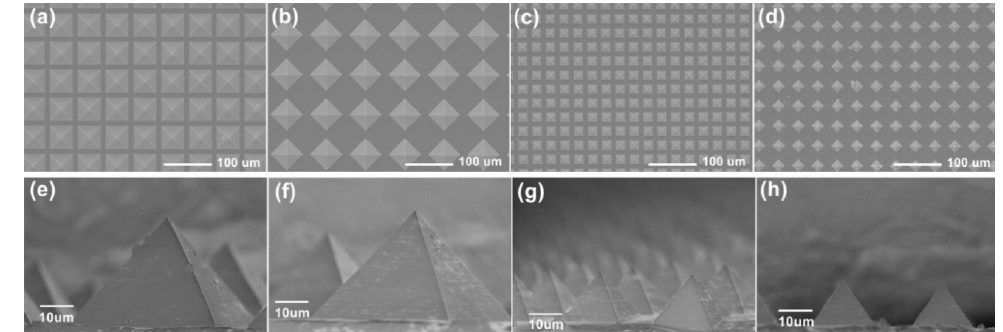
Figure 7. SEM photographs in top view and detail of the pyramid structure with different side lengths and intensive degrees. ( a , e ) 50 μ m, dense; ( b , f ) 50 μ m, sparse; ( c , g ) 20 μ m, dense; ( d , h ) 20 μ m, sparse.